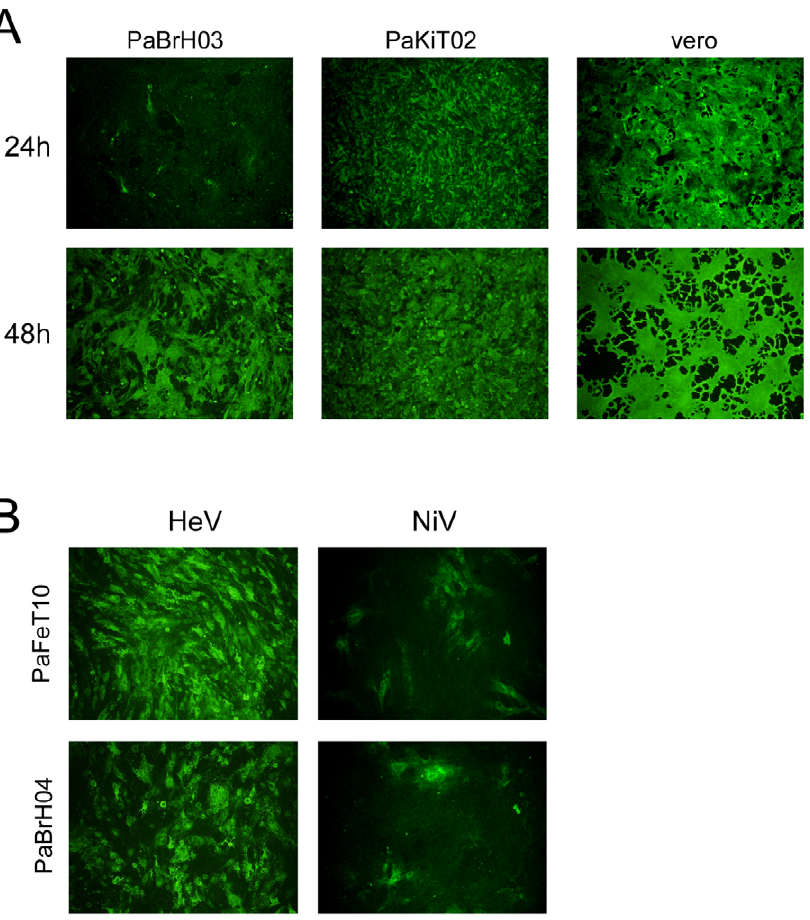
Figure 3. Infection of cloned P.alecto cell lines by HeV and NiV. (A) Comparison of infection kinetics of NiV in three different cell lines at 24 and 48 hours post infection. (B) Comparison of infection efficiency of P. alecto cloned cell lines for HeV and NiV. The images were taken 24 hours post infection. In both studies, cells were infected at high multiplicity of infection (MOI $ 100), fixed with 100% methanol and removed from the Biosafety Level-4 laboratory before being stained with HeV G protein-specific